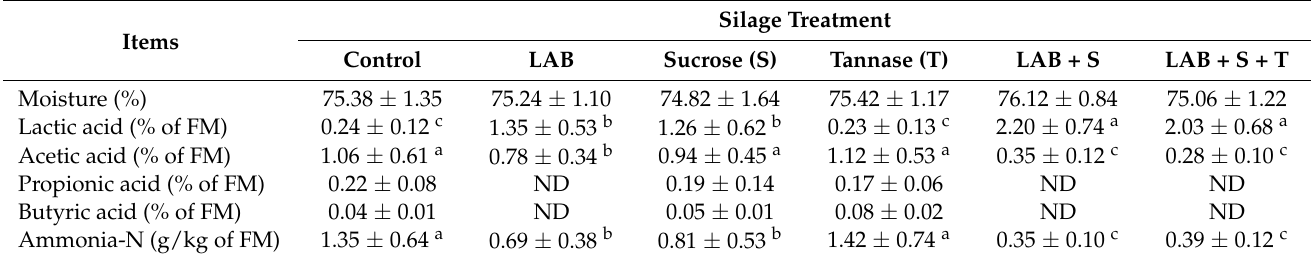
Table 4. Fermentation quality of the defective banana silage after 45 d of ensiling.